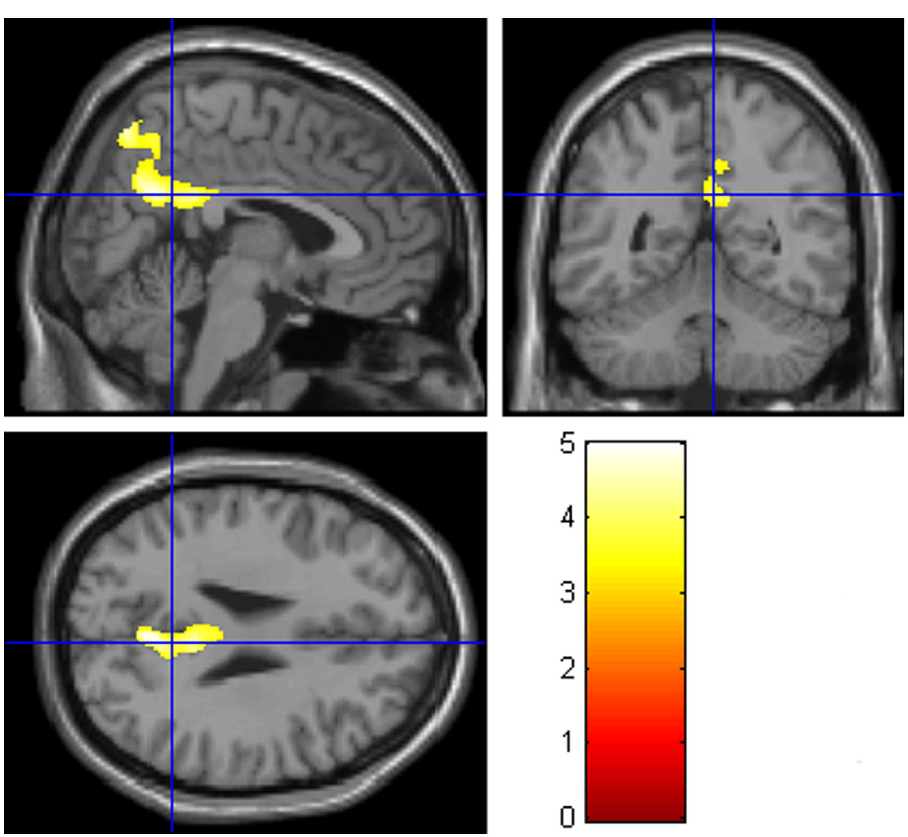
Fig 1. Brain areas that showed smaller GMV in the CCH group than the control group with topological FDR (p < .01). The coordinates of the cross are [5, –51,